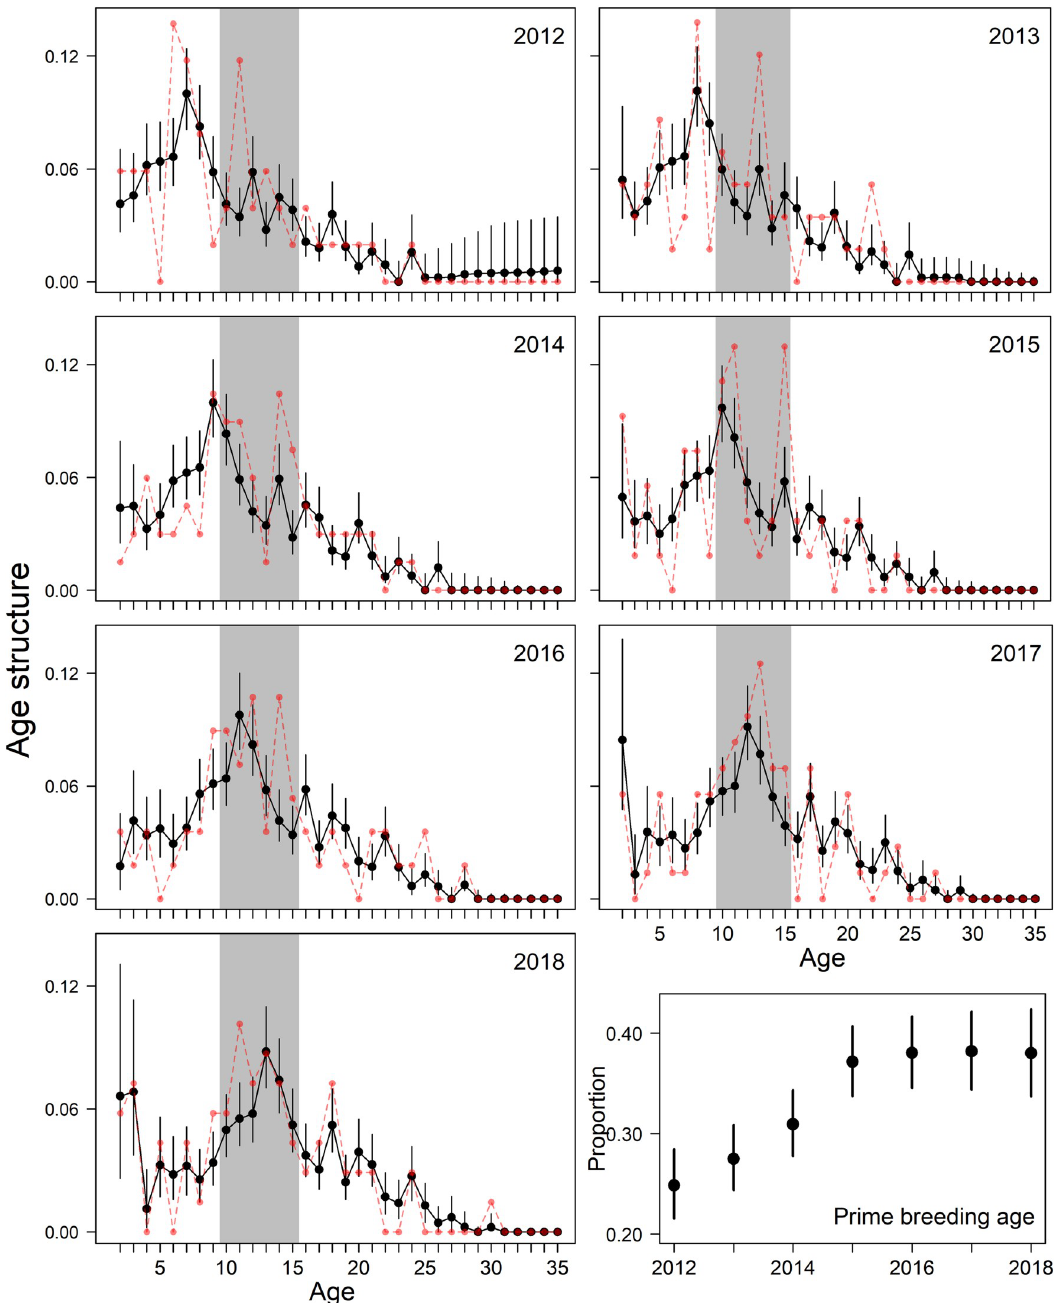
Fig 6. Annual age structure of western Hudson Bay polar bears using an age-structured Jolly-Seber model that assumes annual survival is a quadratic function of age (black; medians and 95% credible intervals). Red points are year-specific proportions from observed data. Grey polygon denotes prime breeding ages (10–15 years of age). The annual proportion of the population in prime breeding age is summarized in lower right panel (median and 95% credible